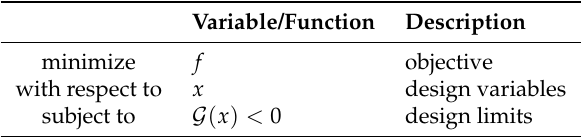
Table 3. Reduced-space optimization problem